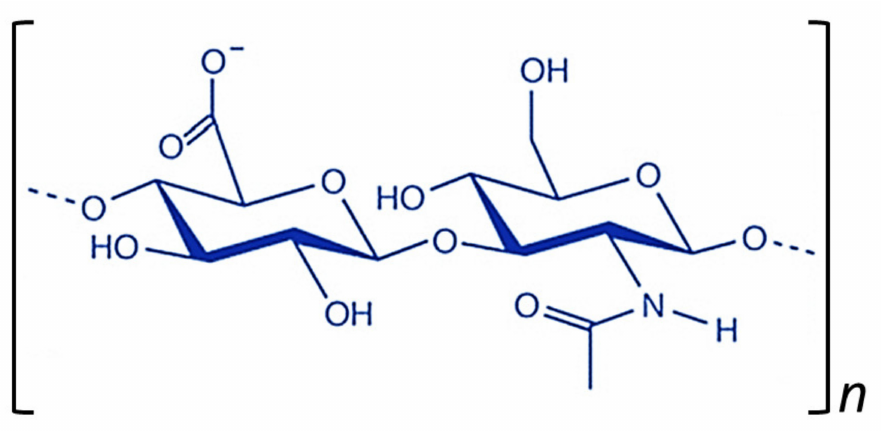
Figure 7. Molecular structure of the disaccharide unit of hyaluronic acid (D-glucuronic acid and N